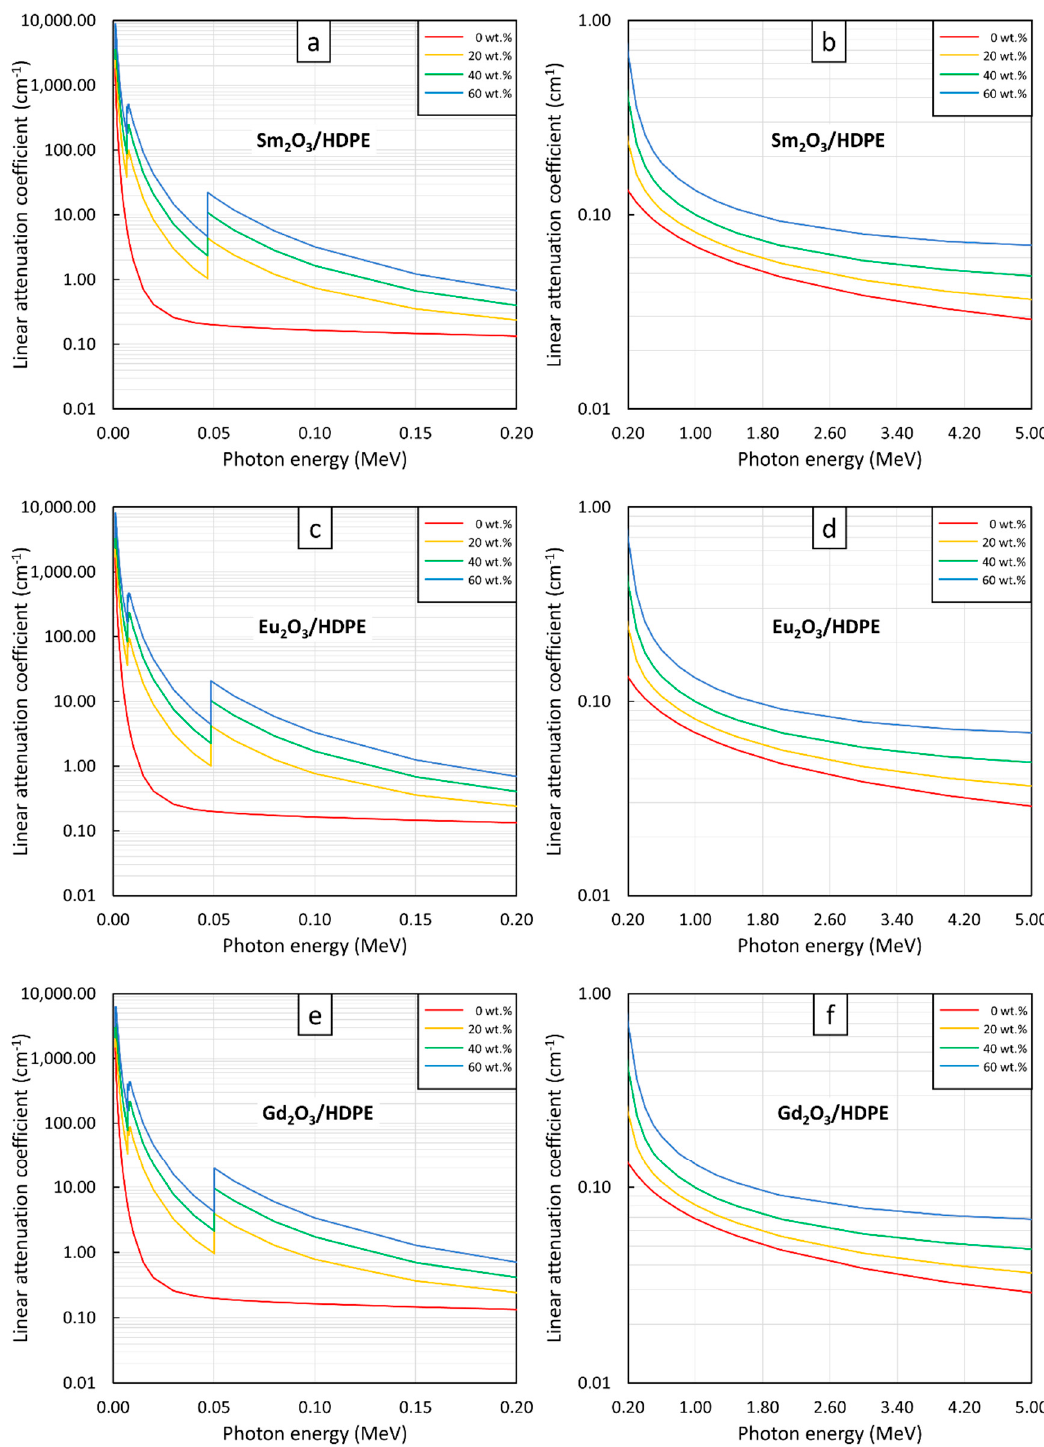
Figure 4. μ values of ( a , b ) Sm 2 O 3 /HDPE, ( c , d ) Eu 2 O 3 /HDPE, and ( e , f ) Gd 2 O 3 /HDPE composites with filler contents of 0, 20, 40, and 60 wt.%, determined at photon energies of ( a , c , e ) 0.001–0.2 MeV and ( b , d , f ) 0.2–5 MeV using XCOM.